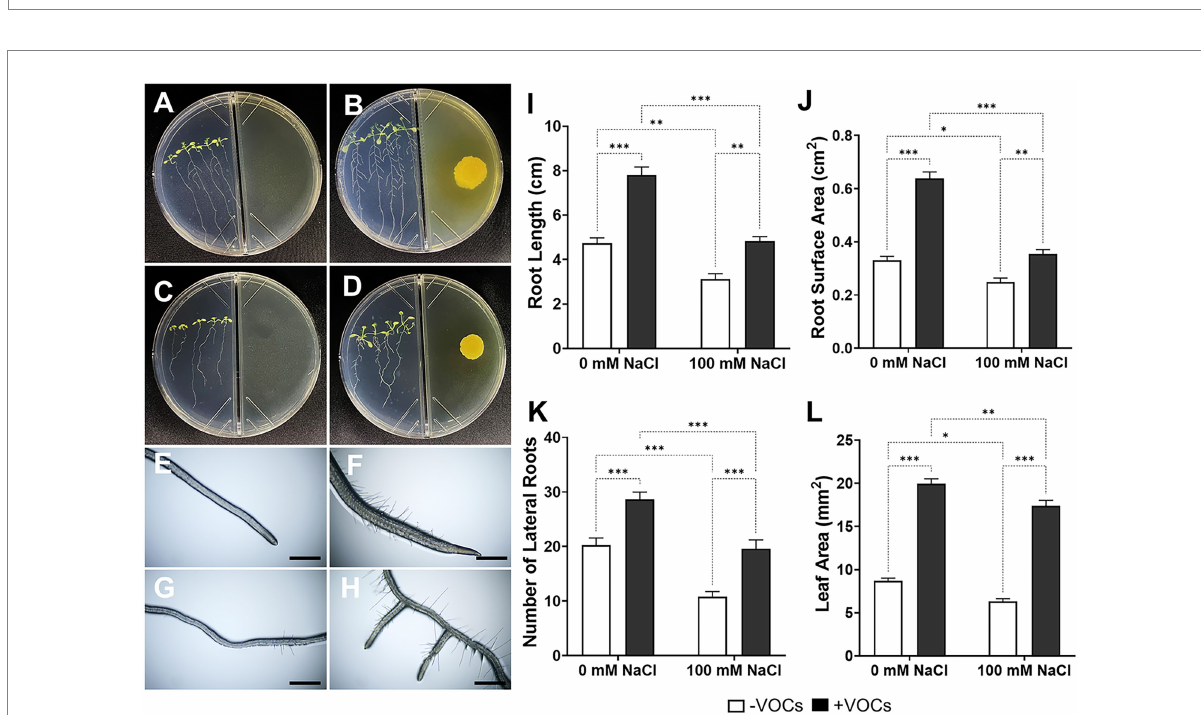
FIGURE 3 Effects of B. pyrrocinia CNUC9 VOCs on growth of A. thaliana seedlings under non-stress (0 mM NaCl) and salt stress (100 mM NaCl) conditions for 10 days. (A–D) CNUC9 VOCs promoted the growth of A. thaliana seedlings. (A) No VOCs exposure; 0 mM NaCl. (B) CNUC9 VOCs exposure; 0 mM NaCl. (C) No VOCs exposure; 100 mM NaCl. (D) CNUC9 VOCs exposure; 100 mM NaCl. (E,F) Root tips under salt stress under (E) no VOCs exposure or (F) CNUC9 VOCs exposure. (G,H) Lateral roots under salt stress under (G) no VOCs exposure or (H) CNUC9 VOCs exposure.